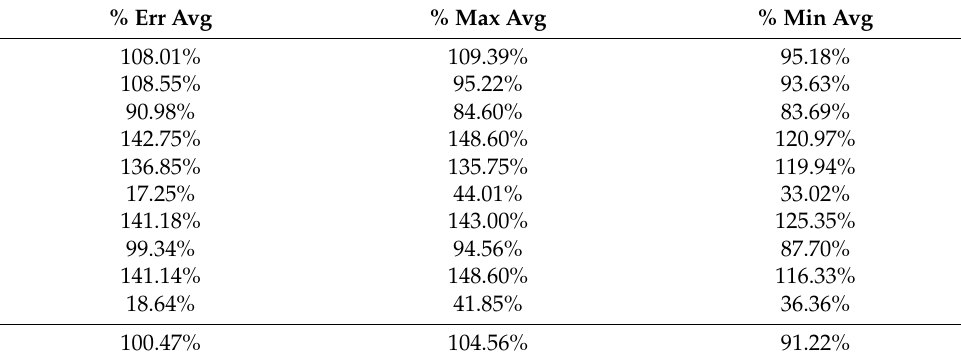
Table A57. Set 1, trials 31–40 data (all 0.5 PR